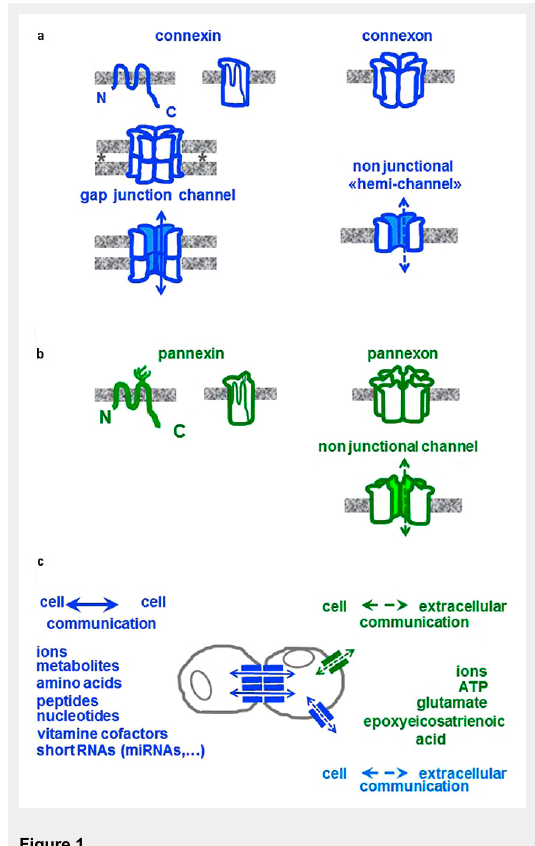
Figure 1 Connexins and pannexins. (a) All connexins (blue) feature 4 domains, which cross the cell membrane (grey) and are connected by one cytoplasmic loop and two extracellular loops. Six connexins oligomerise to form tubular structures, referred to as connexons. Connexons of one cell usually pair with the connexons of an adjacent cell to bridge the intercellular space (asterisks), thus establishing a cell-to-cell, or gap junctional channel. Infrequently, connexons may also be inserted in a non-junctional region of the cell membrane to form “hemi-channels”, which connect cytoplasms to the extracellular medium. (b ) Pannexins (green) show a membrane topography similar to that of connexins, and also oligomerise to form pannexons, similar to connexons. However, pannexins feature glycosylated residues on the